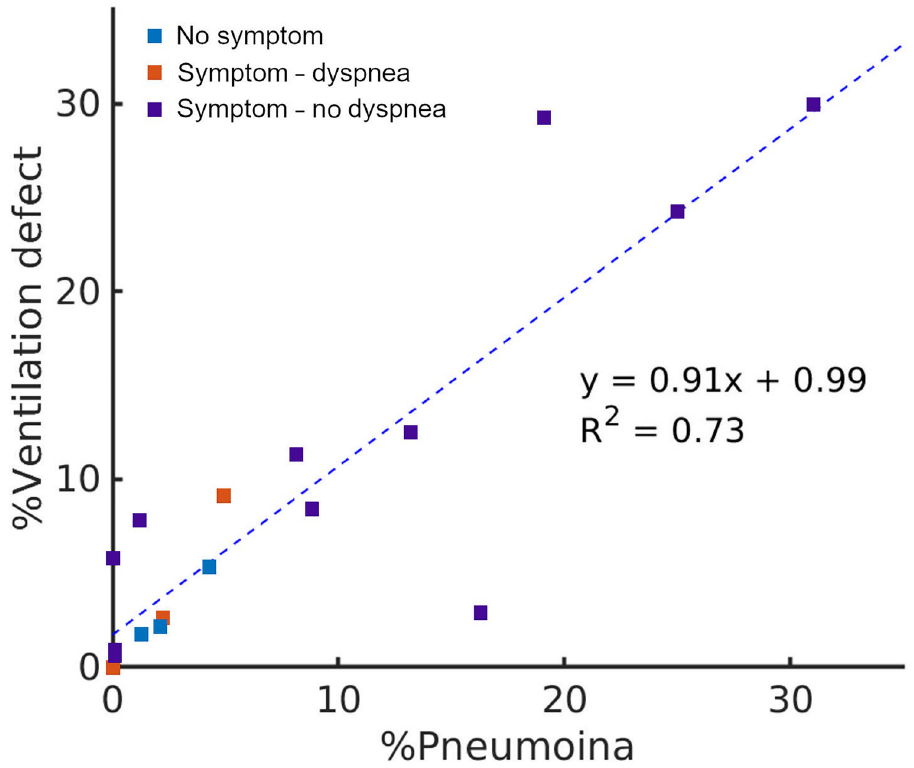
Fig 5. Relationship between %pneumonia (%; x-axis) and %ventilation defect (%; y-axis).